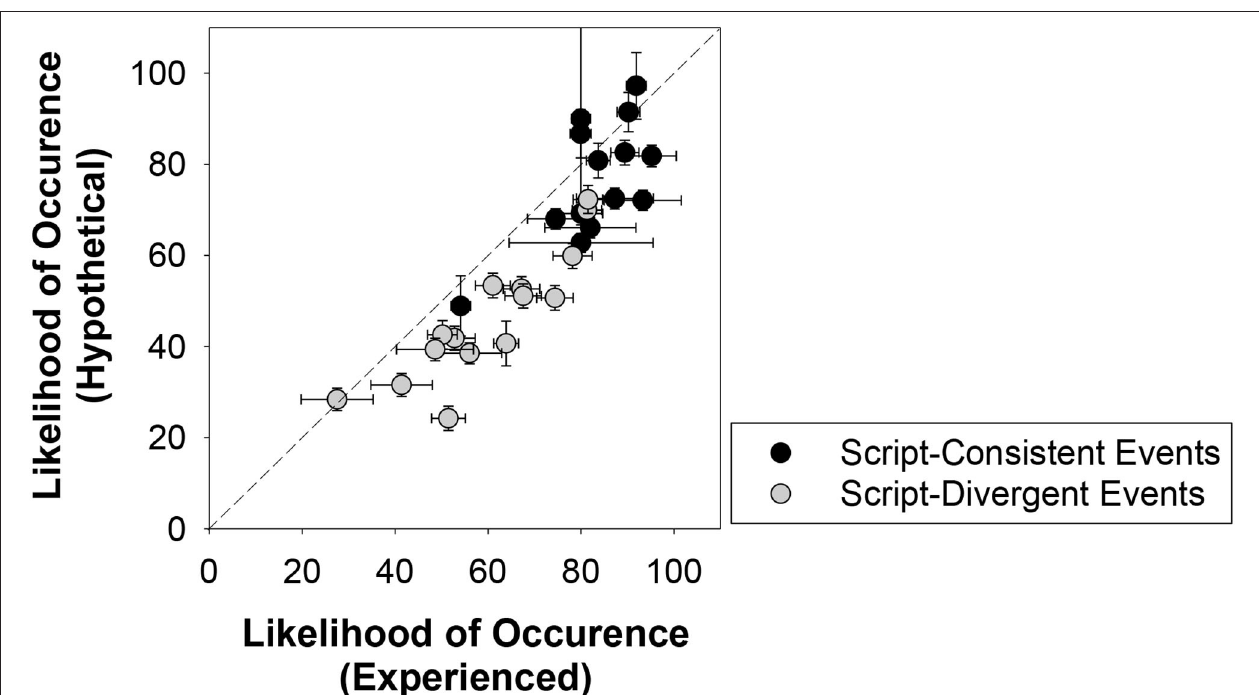
FIGURE 2 | Mean likelihood-of-occurrence of script-consistent and script-divergent events in an average Canadian’s life produced by participants in the experienced and hypothetical conditions. Error bars indicate ± 1 standard error of mean. The event, “begin grade school,” is omitted in this graph because it only has estimates from the experienced condition ( M = 95.04, SE =